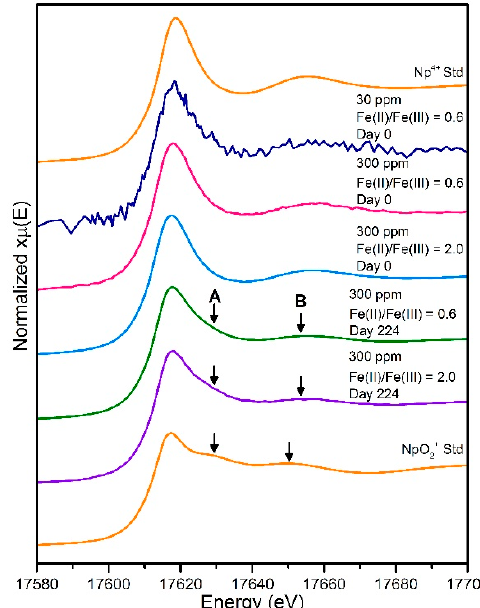
Figure 2. Neptunium L 3 edge XANES spectra collected from 30 ppm and 300 ppm reduced samples and for 300 ppm samples post oxidation (day 224). Reference spectra for aqueous Np 4+ and aqueous neptunyl (NpO 2 + ) are shown for comparison [40]. Arrows indicate the positions of the resonance features of the XANES for A) axial Np-O and B) equatorial Np-O.